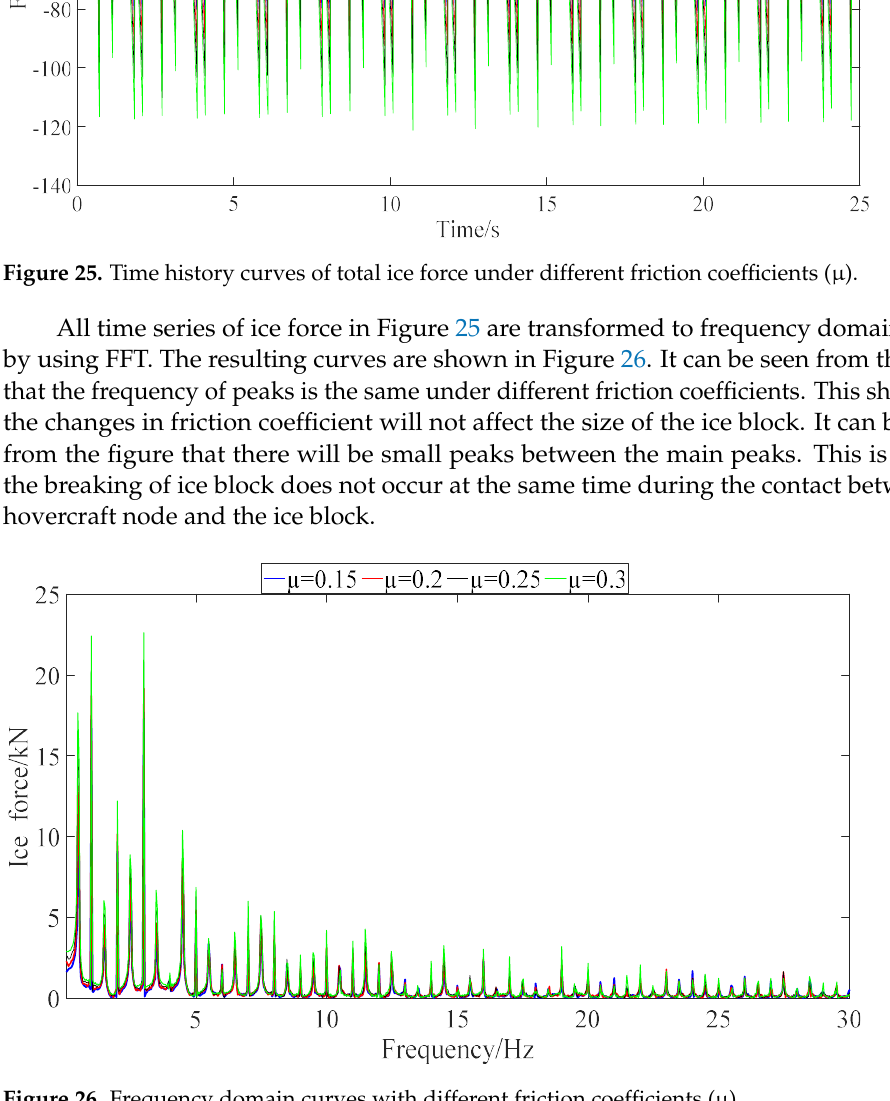
Figure 26. Frequency domain curves with different friction coefficients (µ). Table 10. Statistics of ice force under different friction coefficients (µ).